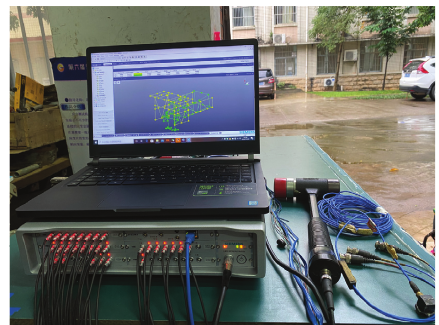
Figure 9: The block diagram of dynamic characteristic experiments of the SSFE and the SSFE II.